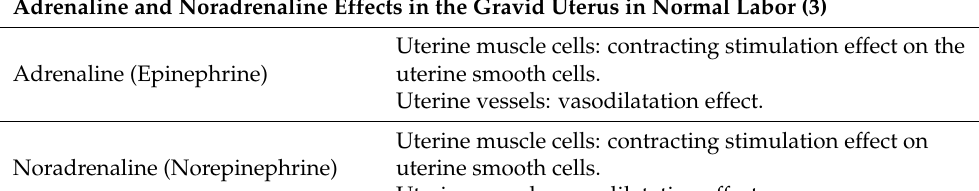
Table 3. Main effects of adrenaline and noradrenaline on the uterine muscular cells and vessels. Adrenaline and Noradrenaline Effects in the Gravid Uterus in Normal Labor (3)